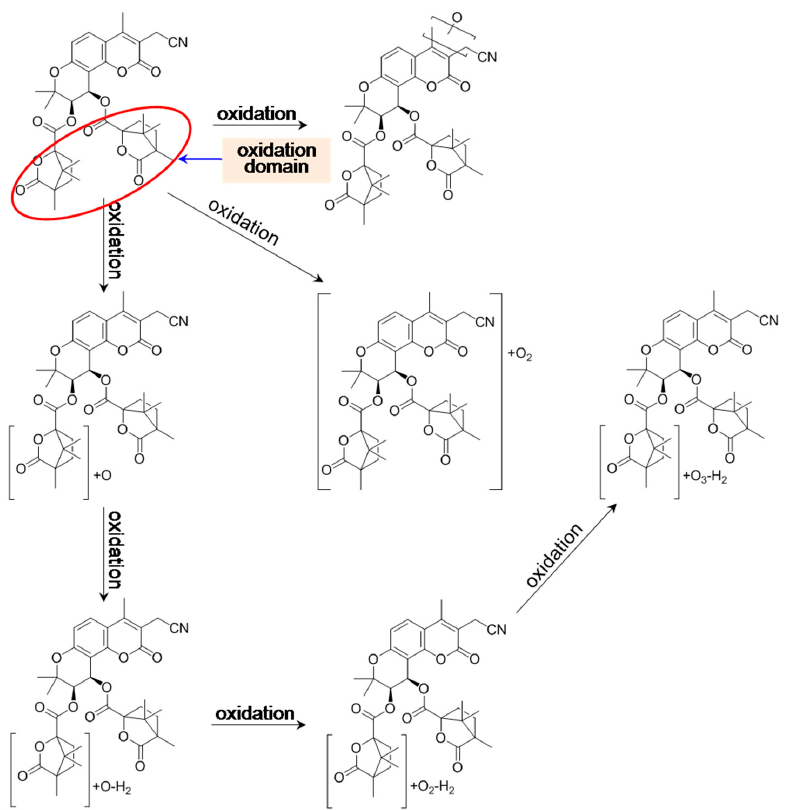
Figure 6. Proposed oxidation-initiated metabolic pathways of 3 ′ ,4 ′ - di - O -( S )-camphanoyl-3-cyanomethyl-4- methyl-(+)- cis -khellactone (CMDCK) in vitro